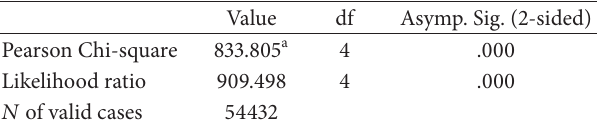
Table 3: Chi-square